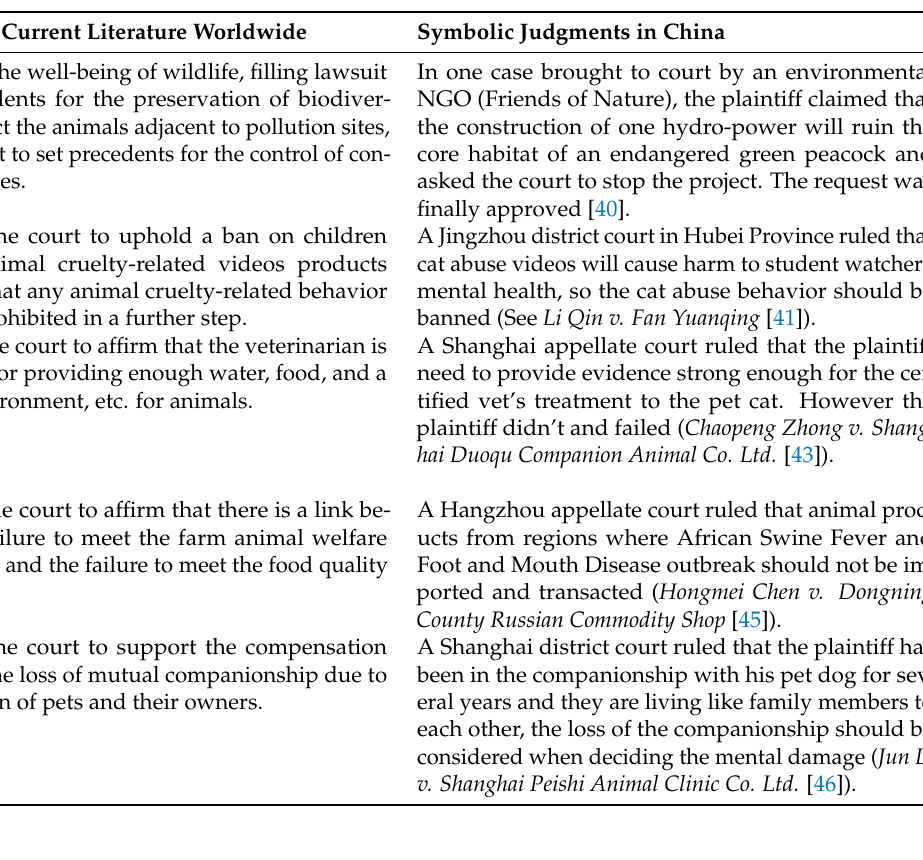
Table 1. Strategic litigations for animal welfare and responses from the court